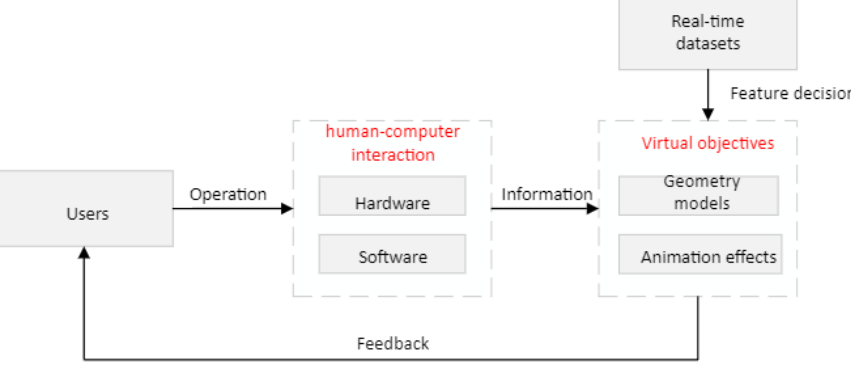
Figure 1. System structure block diagram; the interaction of the dynamic rendering and shader process is given with this illustrative examples. The main procedure covers human–computer interaction and three-dimensional virtual objective